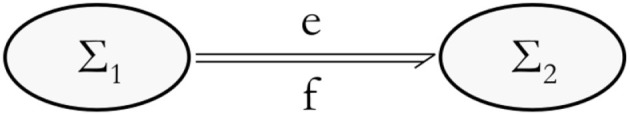
Representation of a power port with a bond (half arrow) indicating a positive power flow from system Σ1 to system Σ2.